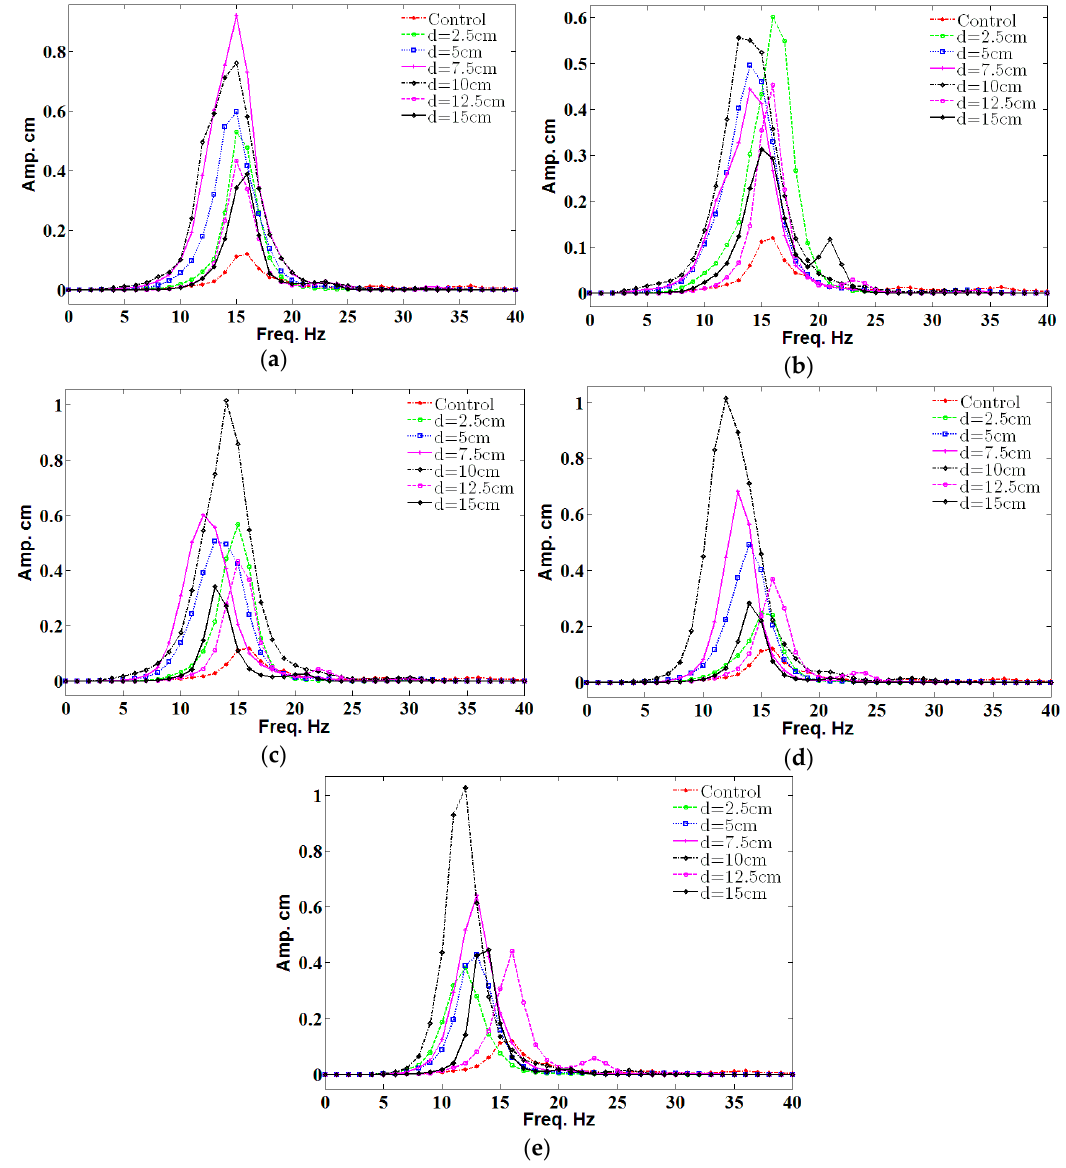
Figure 6. The fluttering amplitude for different diameters of the cylinder. ( a ) Diameter = 1 cm; ( b ) Diameter = 2 cm; ( c ) Diameter = 3 cm; ( d ) Diameter = 4 cm; ( e ) Diameter = 5 cm.